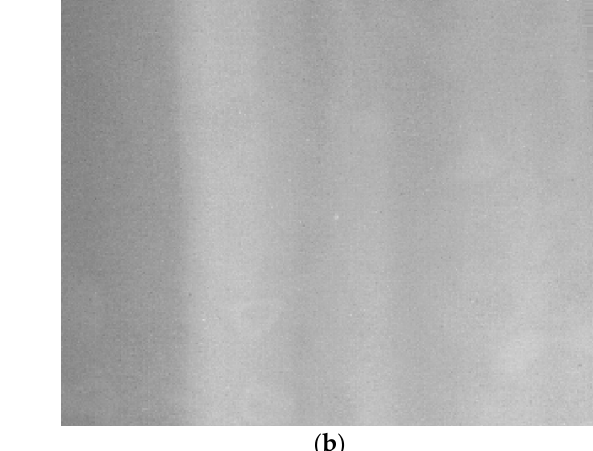
Figure 19. Flight experiment of detecting small and weak target without filter. ( a ) clouds and sky- line; ( b ) close-range non-cooperative goals.